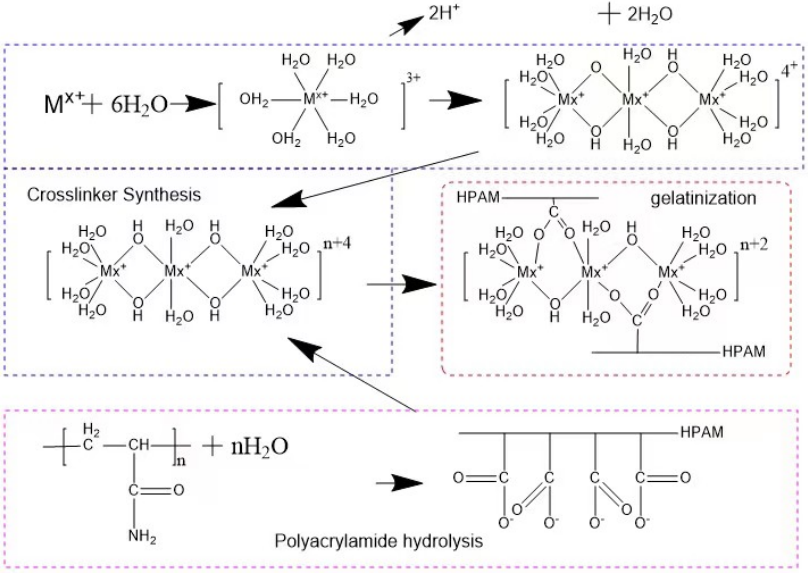
Figure 1. Schematic diagram of cross-linking reaction.